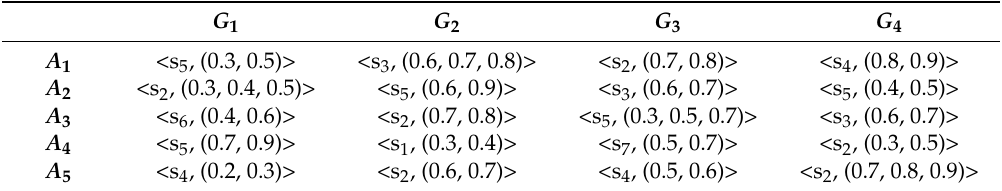
Table 15. Hesitant fuzzy linguistic decision matrix